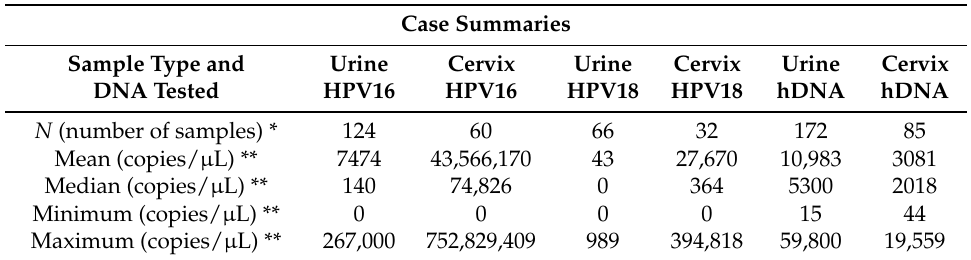
Table 1. Overview of the quantitative PCR results for each of the analyzed parameters, i.e. , HPV16, HPV18 and human DNA (hDNA) in urine and cervical samples (Cervix).